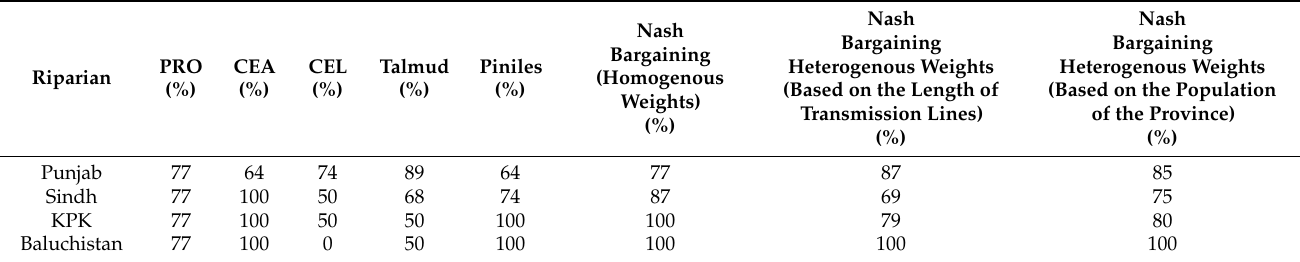
Table 5. Power allocation among the provinces as a percentage of power demand under the five bankruptcy rules and Nash bargaining